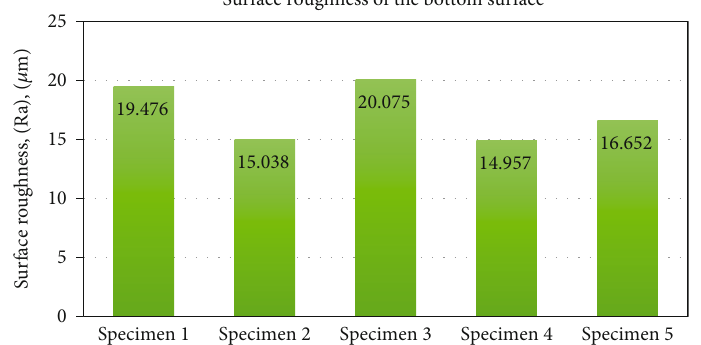
Figure 9: The mean arithmetic deviation ( Ra ) of the bottom surface of the specimens. Table 9: Experimentally determined best process parameters for Laser PP CP 60 based on surface roughness. Temp. of the